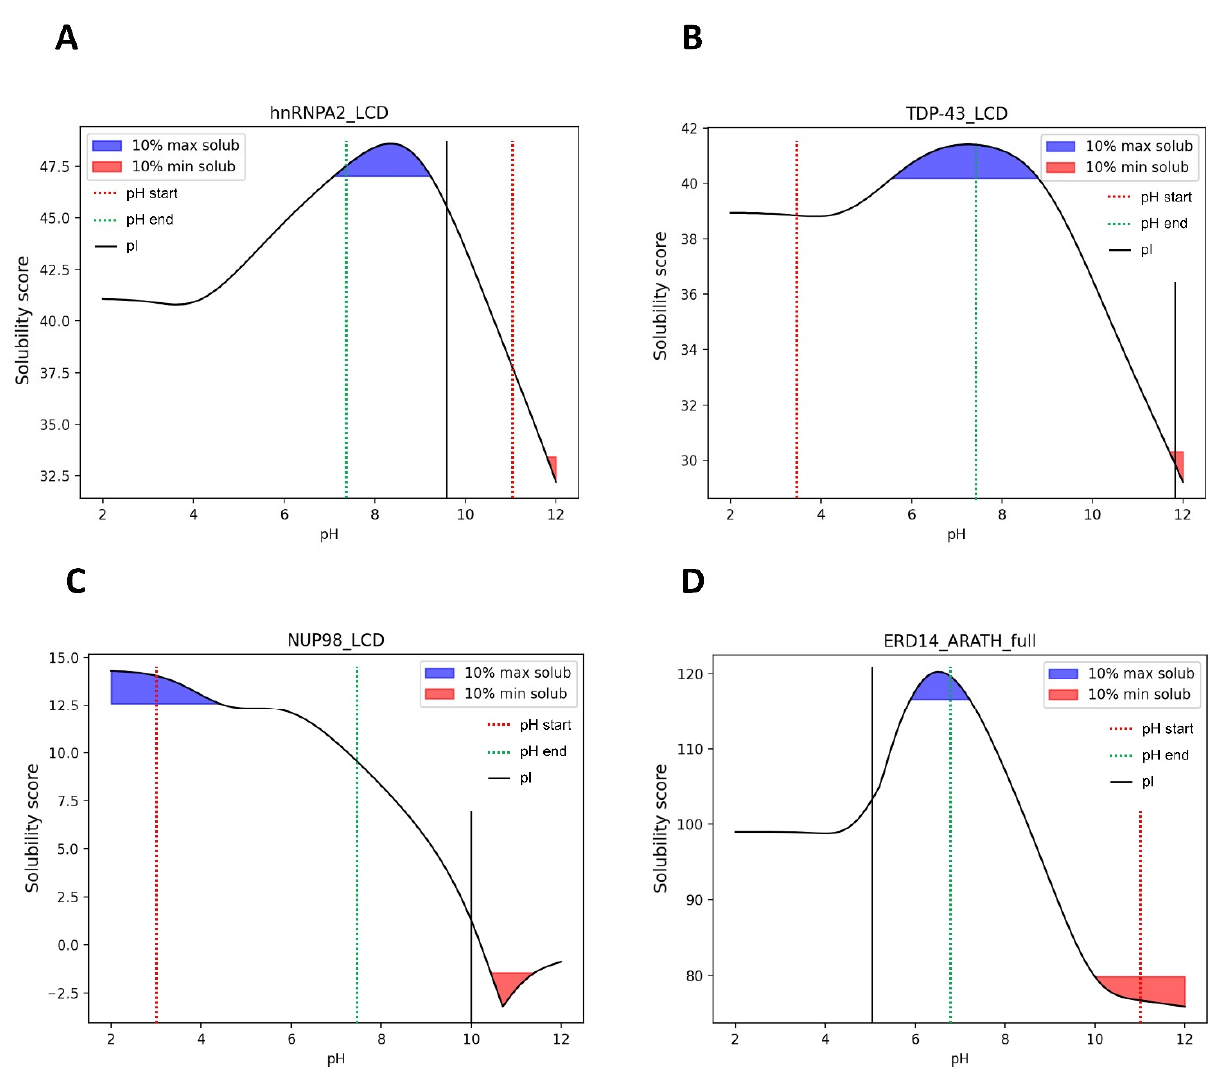
Figure 8. Predicted solubility curves in the pH jump interval for the LCDs of hnRNPA2 ( A ), TDP-43 ( B ), NUP98 ( C ) and ERD14 ( D ). The jump from an extreme pH (dotted red line) to near neutral pH (dotted green line) induces the formation of liquid droplets in conditions within -or close to- 10% maximum solubilities.